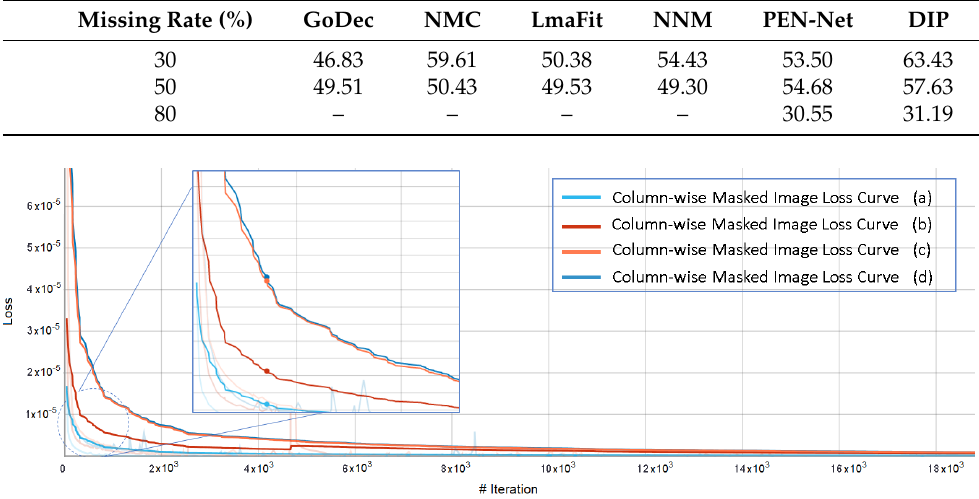
Figure 14. Loss curves for column-wise missing data